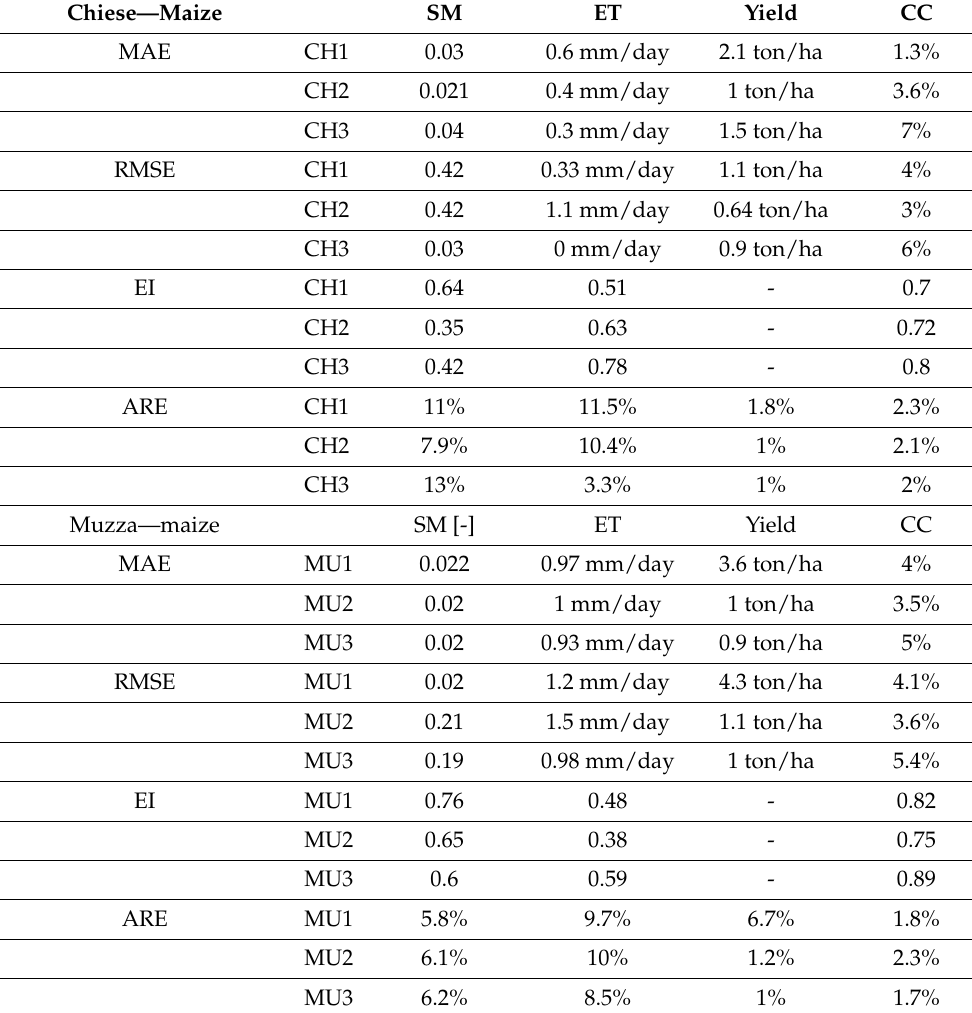
Table 5. Statistical indices results for the model calibration in the Chiese and Muzza Irrigation